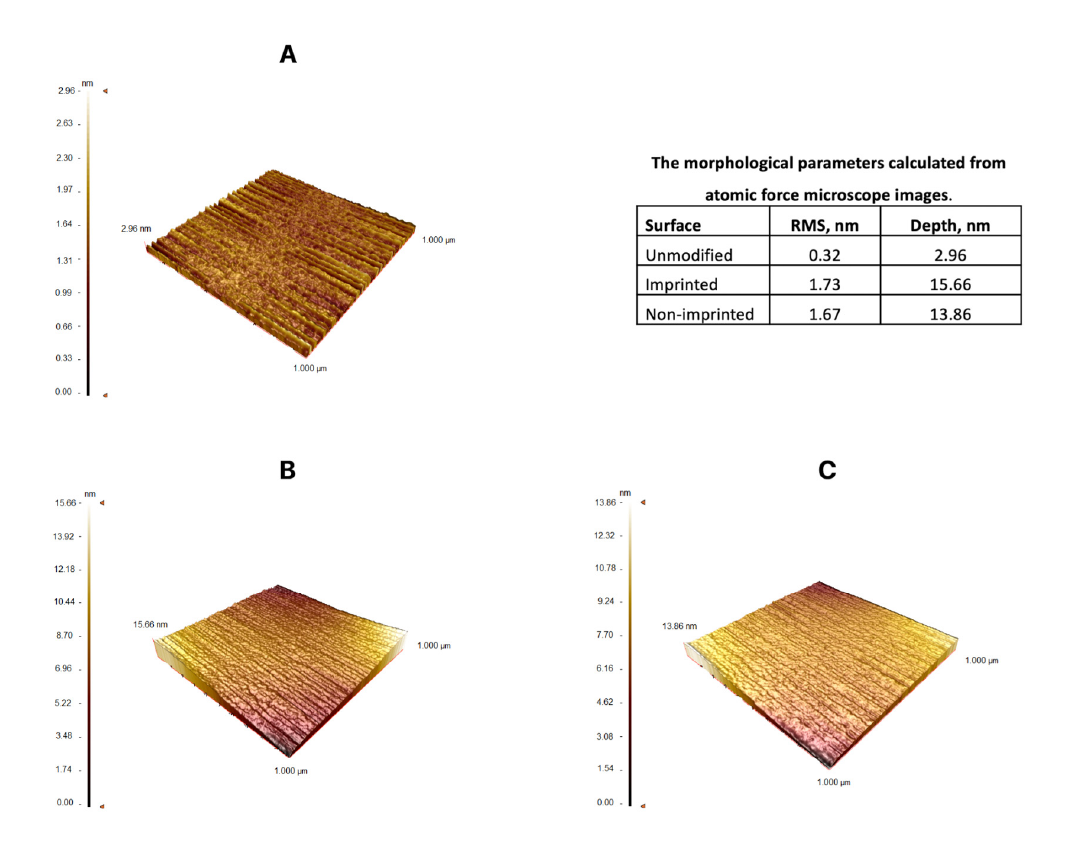
Figure 2. AFM images of SPR sensor surfaces ( A : bare gold SPR surface, B : L -Phe imprinted SPR sensor, C : non-imprinted SPR